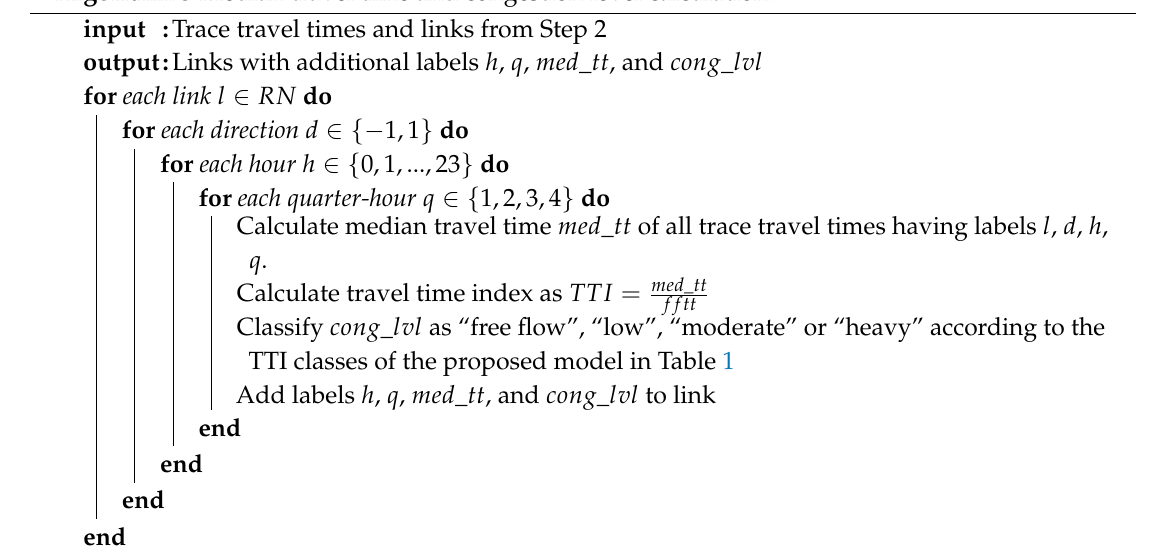
Algorithm 3 Median travel time and congestion level